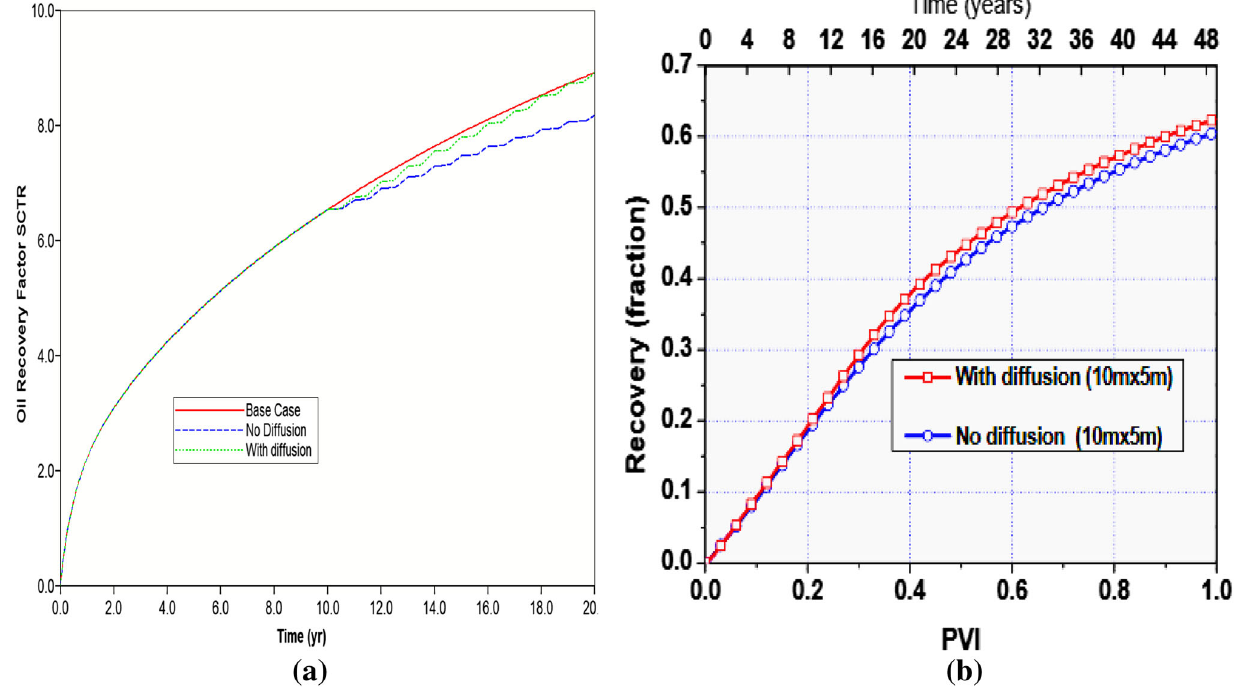
Fig. 12 Effect of molecular diffusion on natural gas-EOR performance: a natural gas performance in shale oil reservoirs—Bakken model, b NG performance in conventional fractured reservoirs (Hoteit and Firoozabadi